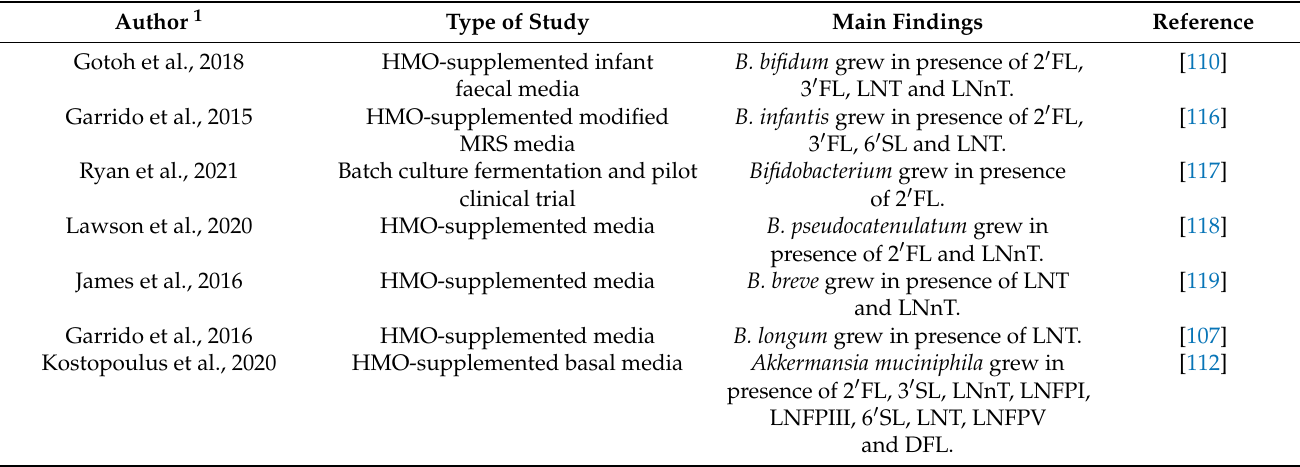
Table 3. Potential HMO utilisers in the